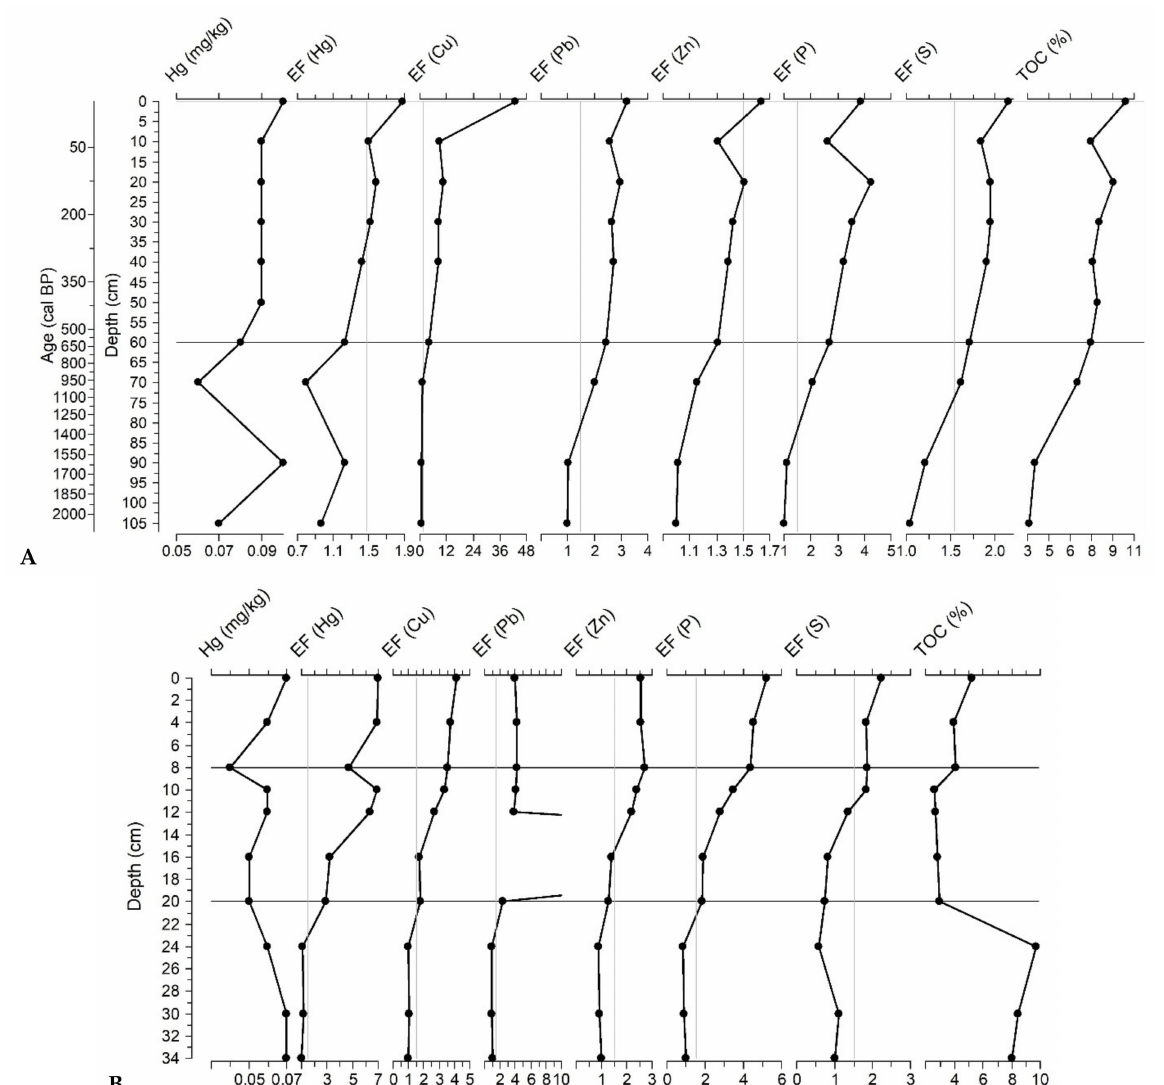
Figure 16. Enrichment factors (EFfs) for Hg, Cu, Pb, Zn, P, and S, as well as concentrations of Hg and TOC in the sediment core from Kolanjsko Blato in depth and age ( A ) and Malo Blato in depth ( B ). Note the reduced maximum value for EF (Pb) to 10 in the Malo Blato sediment core, to emphasize the slight upward-increasing trend, because the value in the interval 16–18 cm is significantly higher (~70). The Hg concentrations in sediments from Velo Blato are mostly low and vary between 0.01 and 0.06 mg/kg, except in high carbonate sediments, where it is even below the detection limit (<0.01 mg/kg). Higher values (0.04–0.06 mg/kg) appear in the lower and upper parts of the sediment core. The same is for sediments from Malo Blato, where the higher values are 0.06–0.07 mg/kg. In Kolanjsko Blato, the Hg concentrations are slightly higher (0.09–0.1 mg/kg) throughout the sediment core. These values correspond to natural background Hg values of karst soils in the Dinaric-coastal region (median value 0.08 mg/kg) as possible natural sources from catchments karst soils [132]. The similar Hg concentrations are recorded in sediment samples from Lake Prokljan as part of Krka River Estuary [66] and in Lake Veliko on Mljet Island [61], while the increased values from industrial sources are recorded in marine sediments from Šibenik Bay [66] and Kaštela Bay [135]. Additionally, the Hg total concentrations in Velo, Malo, and Kolanjsko Blato are slightly higher than the Hg content in marine sediments from Palagruža, middle, and south Adriatic depressions